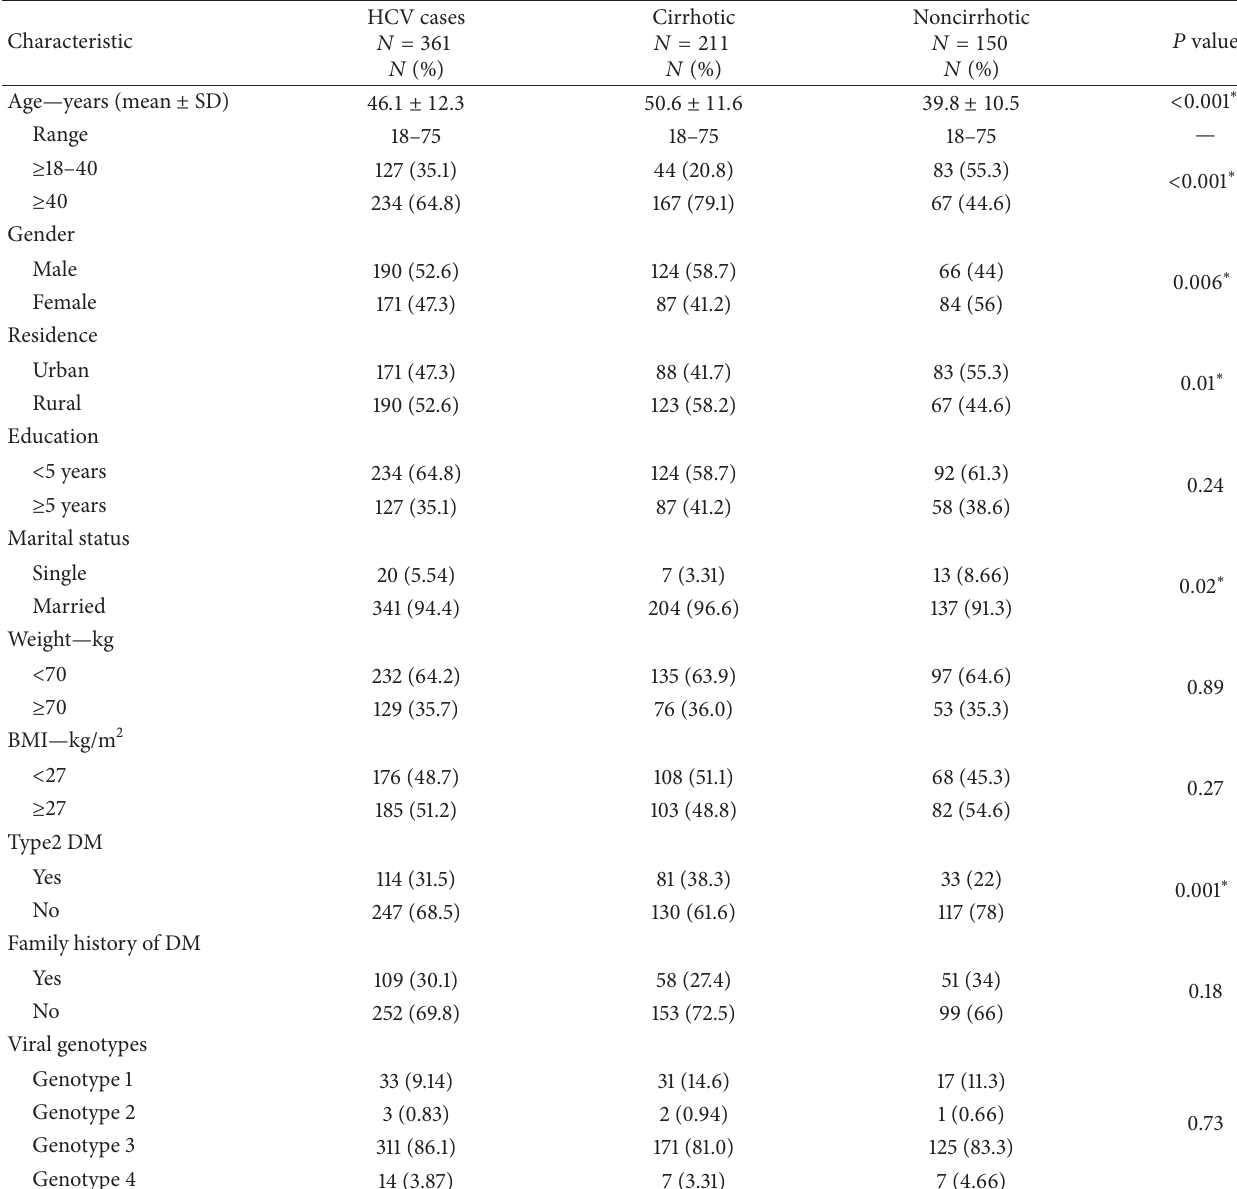
Table 1: Demographic and clinical characteristics of study